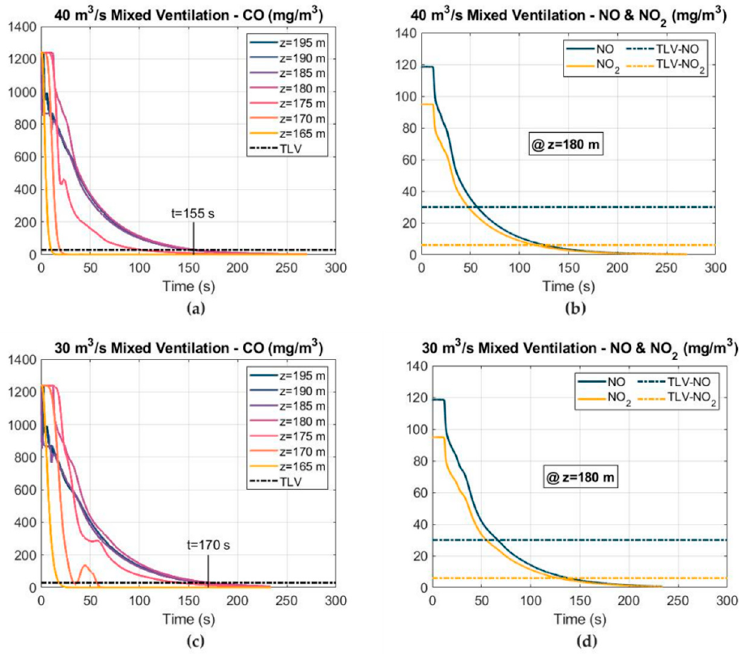
Figure 19. Distribution of the toxic gas mass concentrations and TLVs at different cross sections, under mixed ventilation and using airflows of 30 and 40 m 3 s − 1 : ( a ) CO mass concentration at 40 m 3 s − 1 ; ( b ) NO and NO 2 mass concentrations at 40 m 3 s − 1 ; ( c ) CO mass concentration at 30 m 3 s − 1 ; and ( d ) NO and NO 2 mass concentrations at 30 m 3 s − 1 .